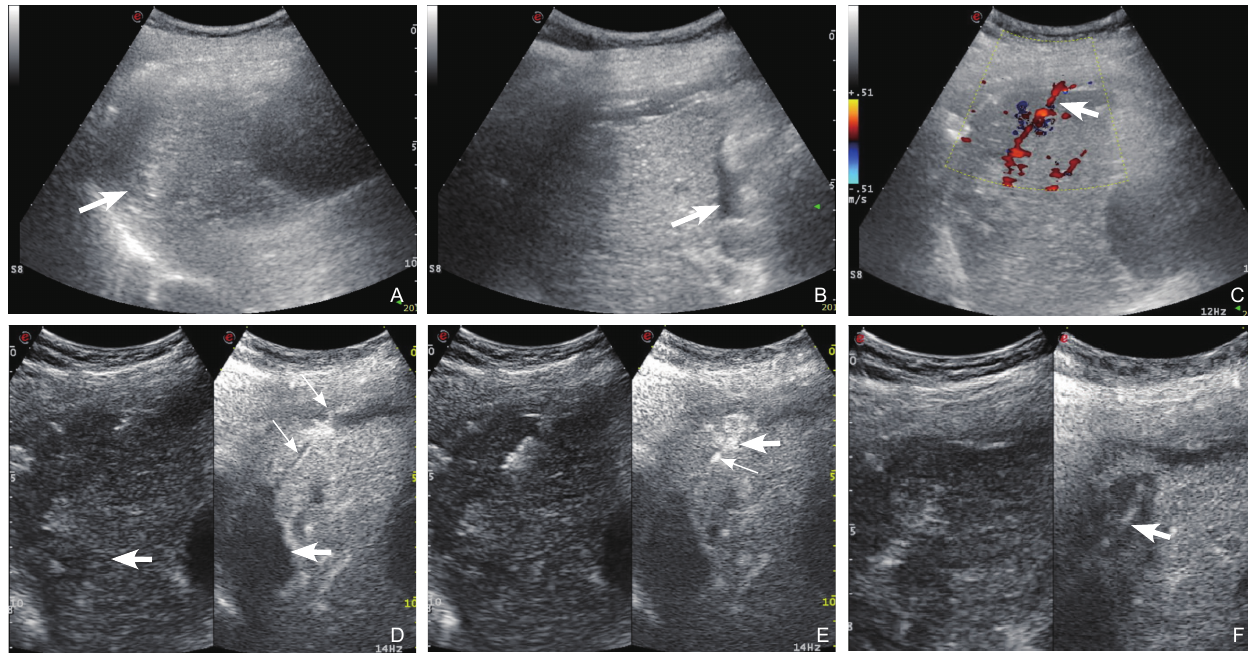
Figure 1 A 69-year-old female with abnormal coagulation function (platelet count was 46 × 10 9 /L). (A) There was no free fluid surrounding the liver at the beginning of ablation. The arrow shows the index lesion in segment 8; GB: gallbladder; (B) Newly developed fluid areas were seen between the liver and gallbladder after retracting the cool-tip RFA electrode; (C) Colour Doppler US showed the signal of hepatic blood flow from the needle tract to the liver capsule; (D) The ultrasound microbubbles were observed to continuously overflow from the ablation site to the liver surface. The short arrow showed the ablation zone, and the long arrows showed the overflowing microbubbles in the needle tract and outside of the liver surface; (E) The needle tract was ablated under the guidance of CEUS. The long arrow showed a part of the needle tract, and the short arrow showed the tip of the RFA electrode; (F) The ANTB was stopped successfully after ablation for approximately 2 min. The arrow showed the carbonized liver tissue.